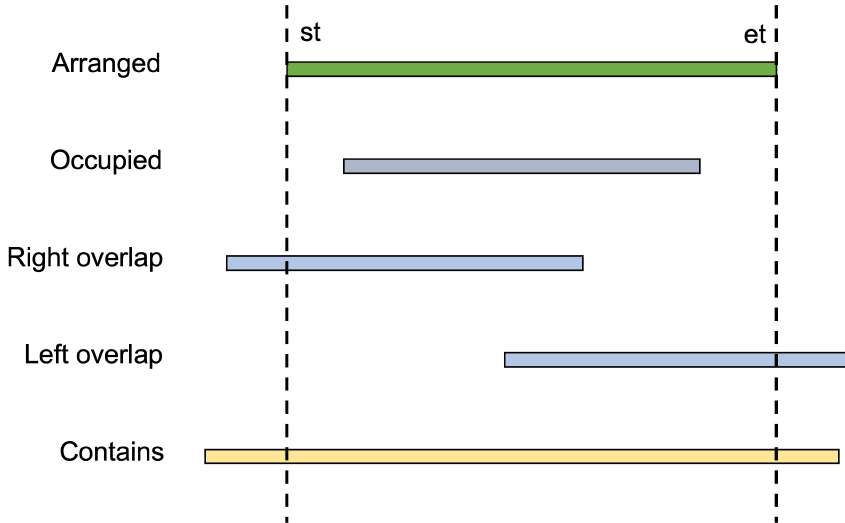
Figure 4. Time window conflict type.